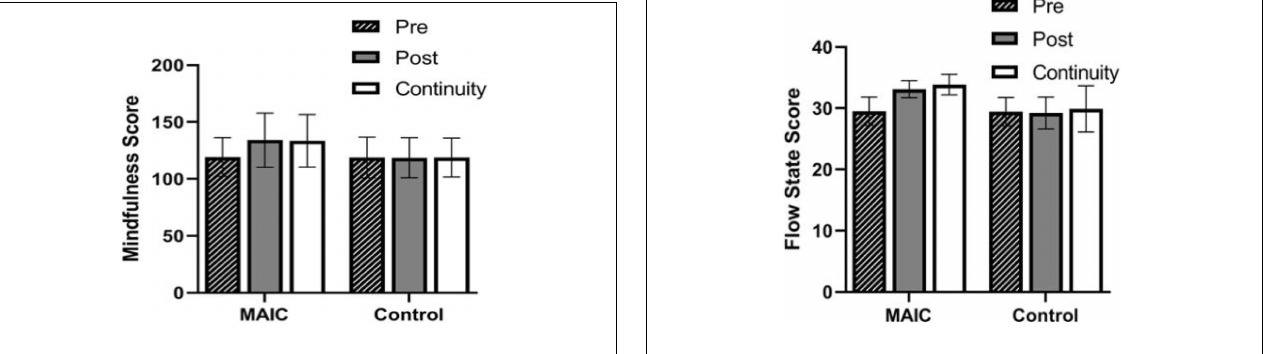
FIGURE 2 | Comparison of mindfulness scores between the MAIC and control groups.